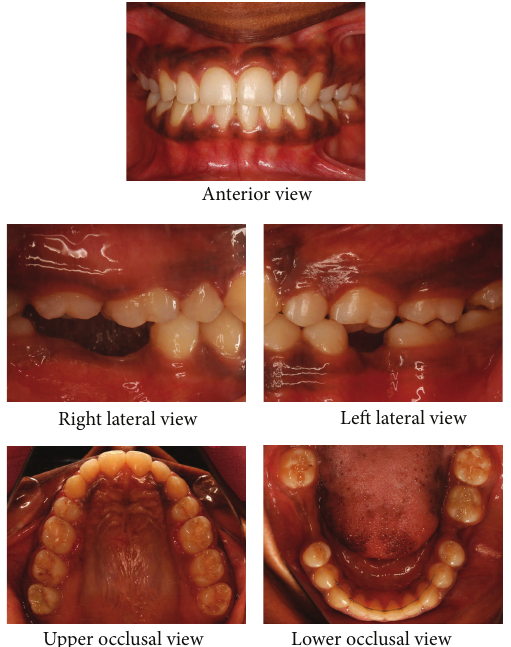
Figure 7: Posttreatment intraoral photographs: without removable cast partial denture.